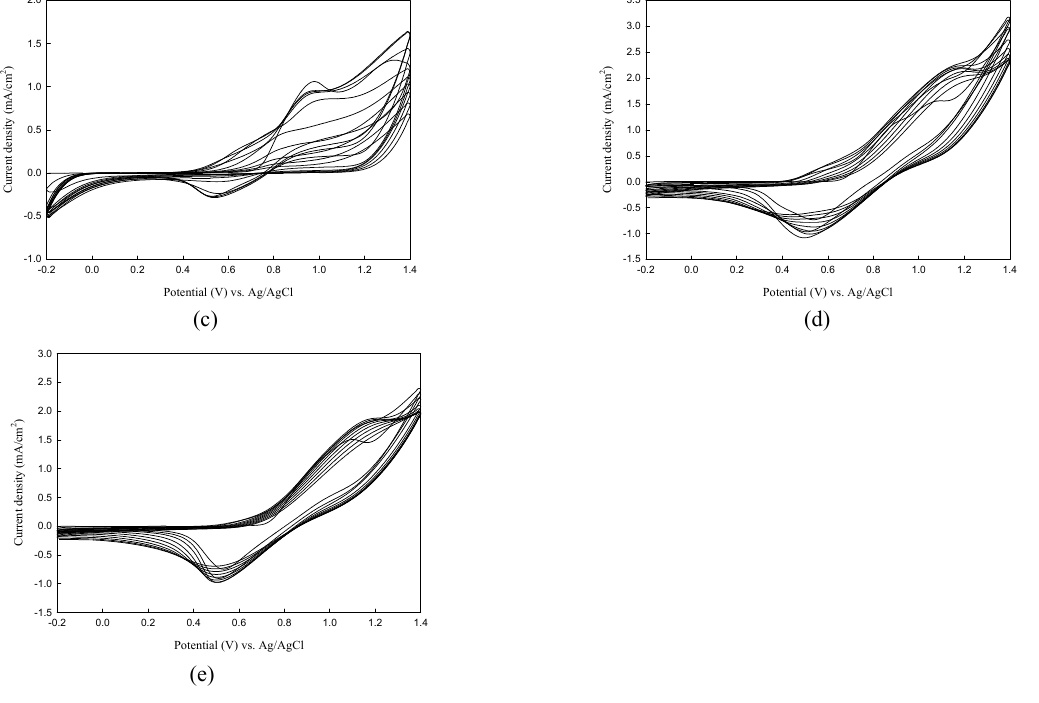
Figure 1. Cyclic voltammograms of: ( a ) 2 mM tris(4-(thiophen-2-yl)phenyl)amine (TTPA); ( b ) 2 mM 1-(2,3-dihydro-inden-4-yl)-2,5-di(thiophen-2-yl)-pyrrole (DIT); ( c ) 2 mM 4-(2,5-di(thiophen-2-yl)-pyrrol-1-yl)benzo[c][1,2,5]thiadiazole (BDTA); ( d ) 2 mM TTPA + 2 mM DIT; and ( e ) 2 mM TTPA + 2 mM BDTA in 0.1 M LiClO 4 /ACN at a scan rate of 100 mV s − 1 on ITO working electrode.